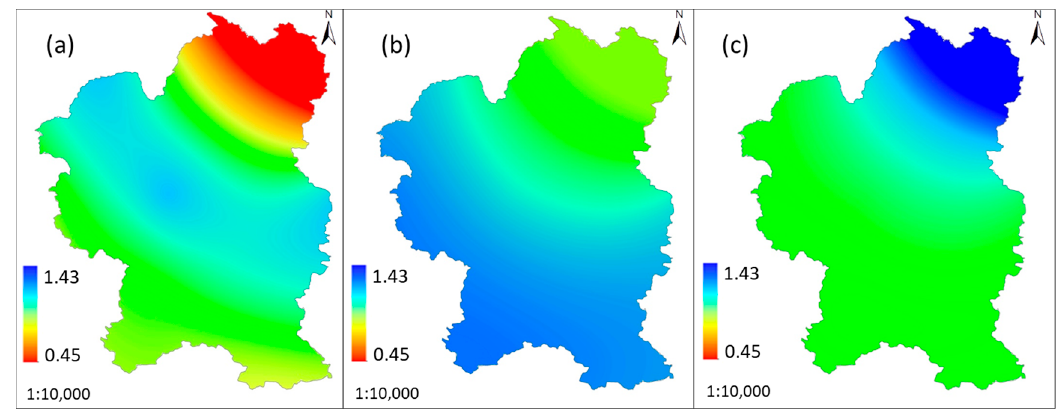
Figure 3. Distribution of rainfall influence factor in the study area (( a ) 2011; ( b ) 2012; ( c ) 2013).